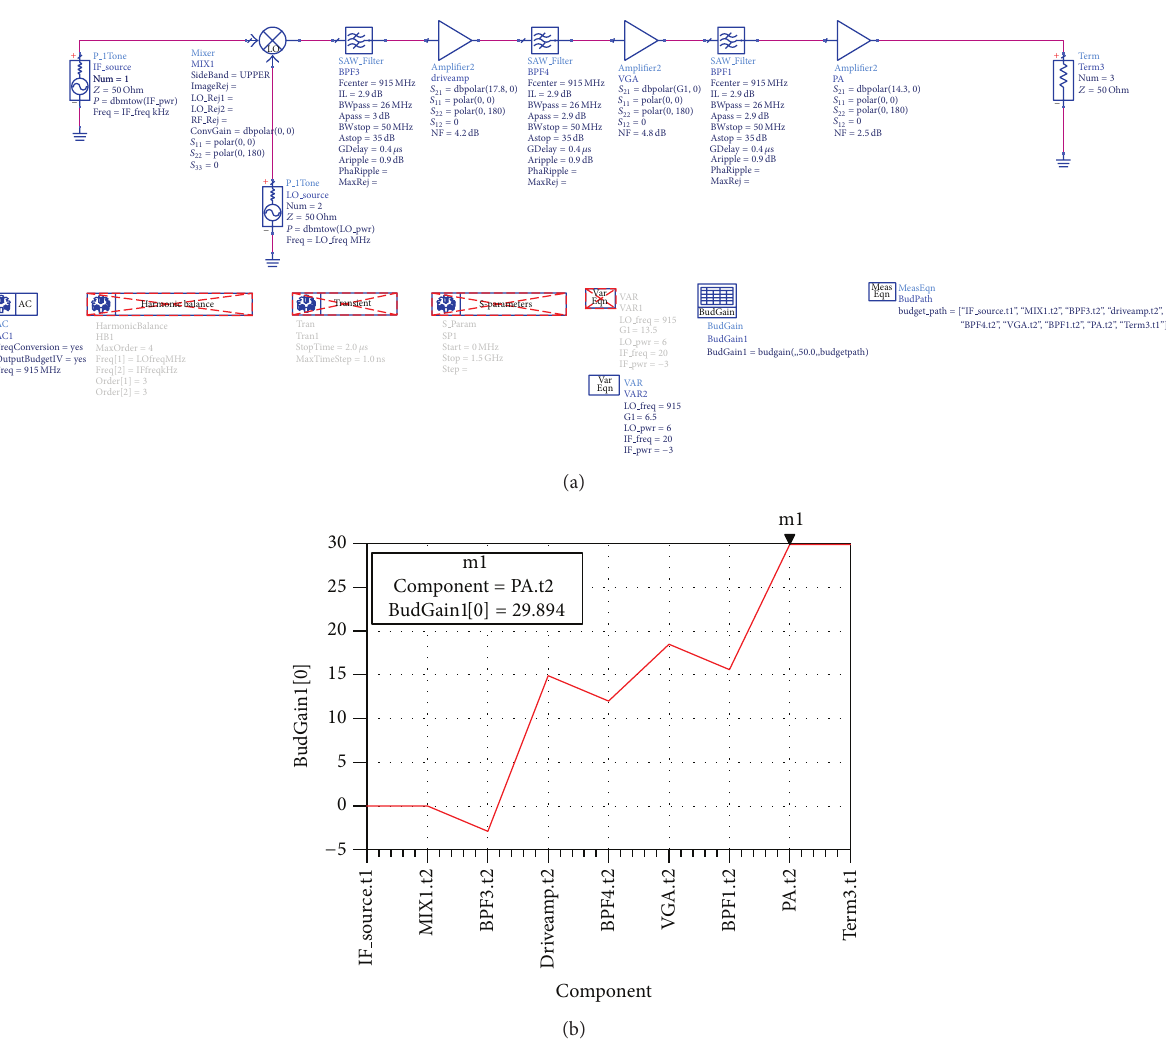
Figure 3: Link budget simulation of the proposed Tx circuit: (a) behavior model of the Tx circuit; (b) simulation result when VGA sets a 6.5dB